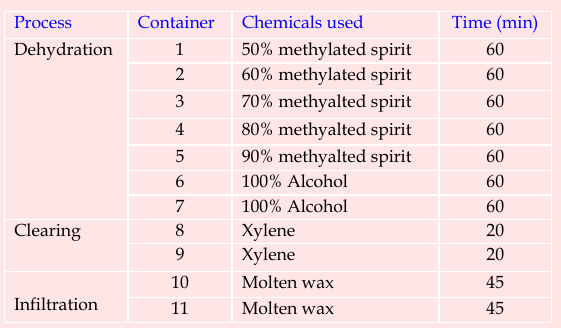
Table I: Time schedule in the automatic tissue